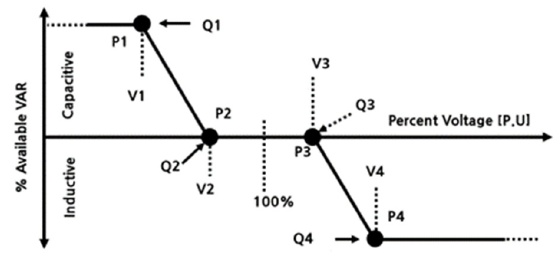
Figure 1. Schematic illustrating the volt–var control (VVC) function. V1, V2, V3, and V4 are the boundary of the minimum PCC voltage (P1), the start of the low voltage set point (P2), the start of the high voltage set point (P3), and the boundary of the maximum PCC voltage (P4), respectively; Q1 and Q2 are the maximum capacitive and induced power generation of the inverter, respectively; the reactive power output is the dead zone where outputs of Q2 and Q3 are zero in the voltage range from V2 to V3.